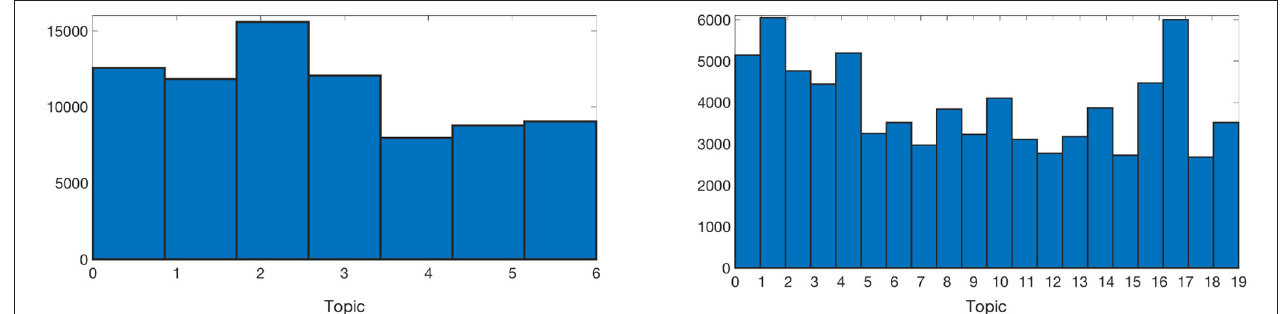
FIGURE 1 | The number of posts that are primarily assigned to each topic for n = 7 (Left) and 20 (Right) .